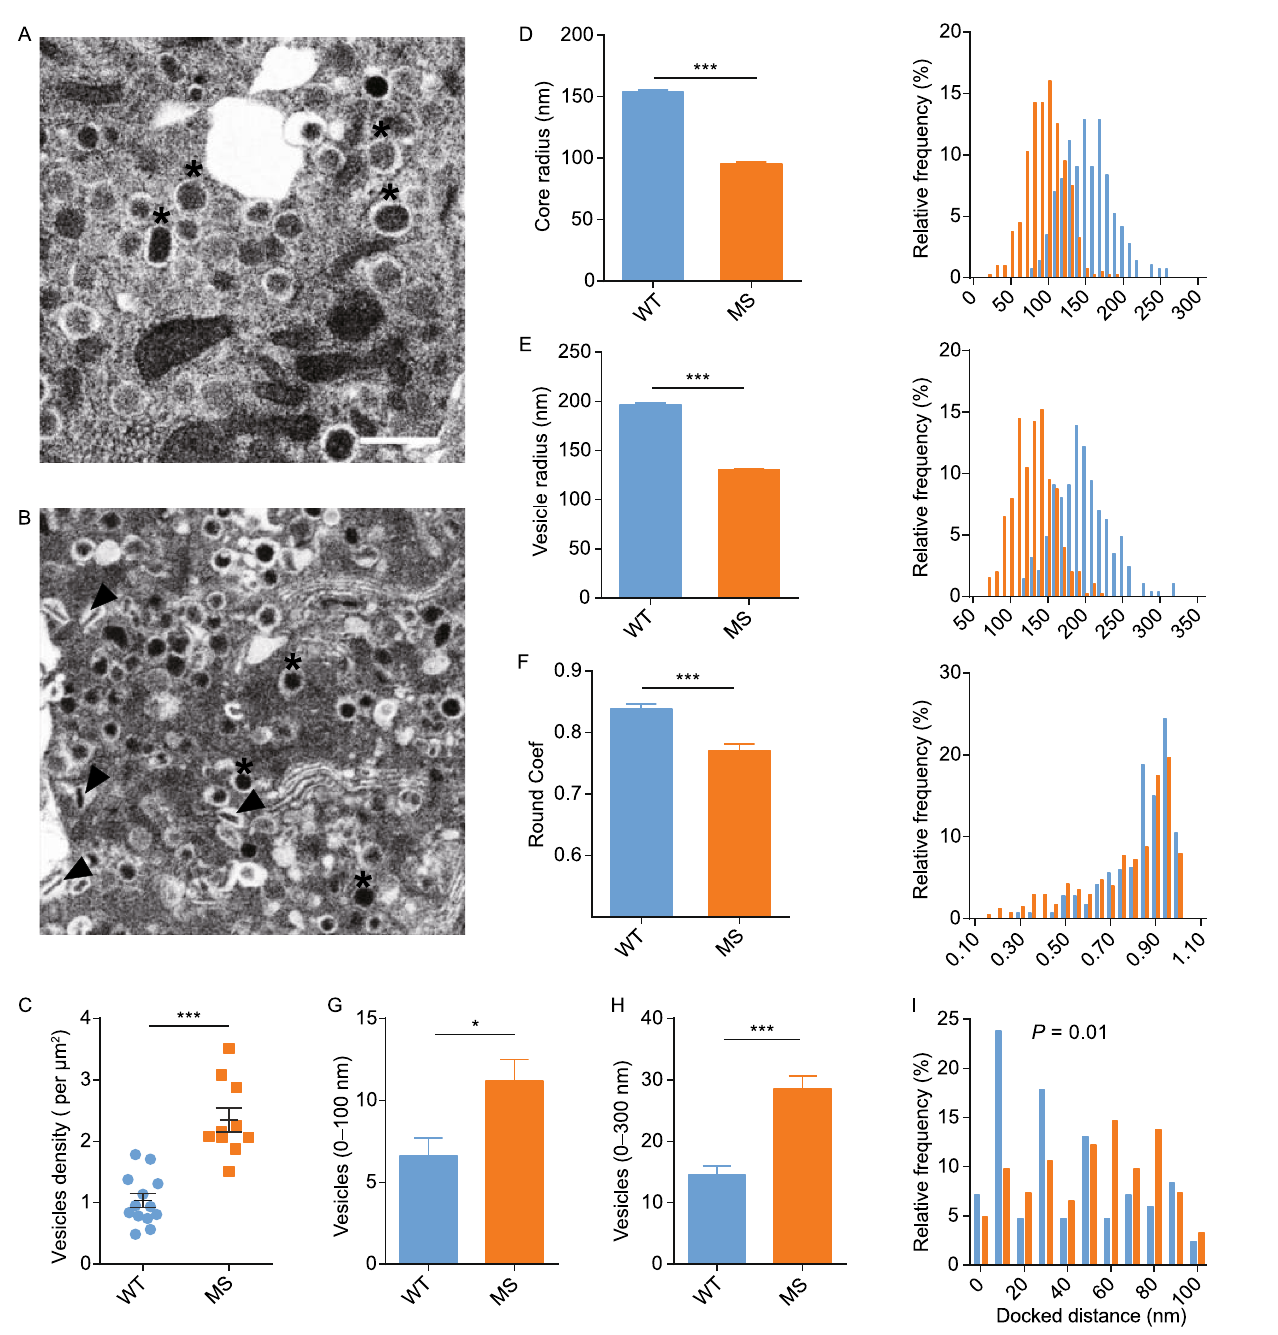
Figure 2. Quantitative comparison of insulin granules from beta cells of WTand spontaneous MS rhesus monkeys . (A and B) Representative EM images of WT (A) and MS (B) beta cells. Typical normal, symmetric and round granules were labeled by asterisks, and whole granules of abnormal shapes were indicated by arrowhead. Scale bar, 1 μ m. (C) Density of insulin granules ( n = 958) in MS monkey beta cells ( n = 10) is signi fi cantly higher than that ( n = 627) in WT cells ( n = 13) ( P < 0.001 by Student ’ s t -test). (D) Average (left) and distribution (right) of radius of dense-cores, in which MS beta cells displayed a signi fi cant left-shift distribution ( P < 0.0001 by Kolmogorov-Smirnov test). (E) Average (left) and distribution (right) of radius of insulin granules, in which MS beta cells again displayed a signi fi cant left-shift distribution ( P < 0.0001 by Kolmogorov-Smirnov test). (F) Average (left) and distribution (right) of round coef fi cient of insulin granules, in which MS beta cells exhibited an irregular shape ( P < 0.0001 by Kolmogorov-Smirnov test). (G and H) In MS beta-cells ( n = 11), there were absolute increase in numbers of granules that resided ∼ 100 (G) and ∼ 300 nm (H) within the plasma membrane compared with WTones ( n = 13). (I) WT beta-cells exhibited more enrichment of granules that were less than 40 nm to the plasma membrane as compared with the MS ones. ( P = 0.01 by Kolmogorov-Smirnov